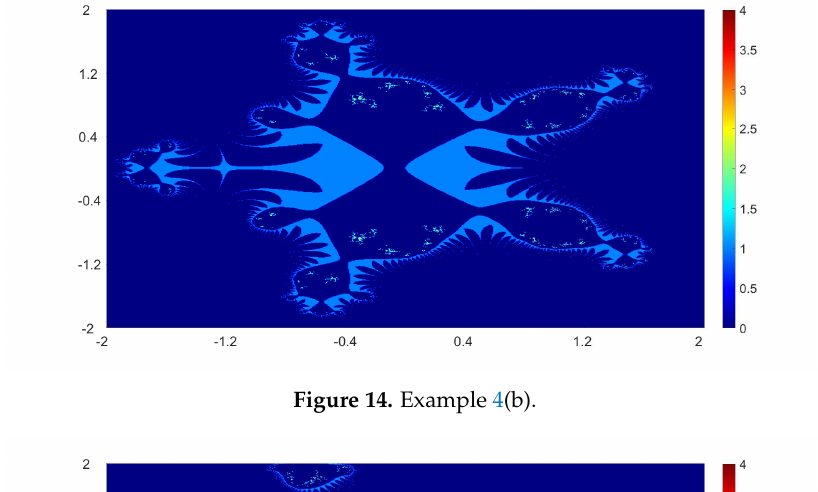
Figure 14. Example 4(b).